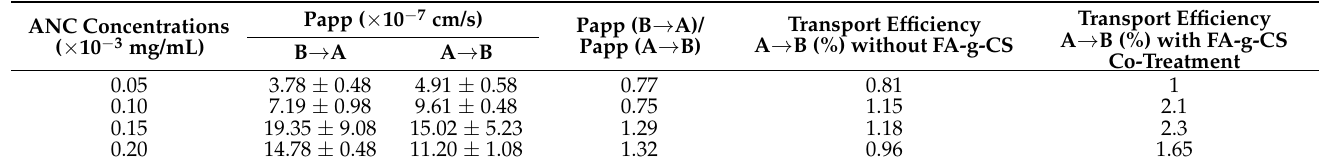
ANC Concentrations ( × 10 − 3 mg/mL)